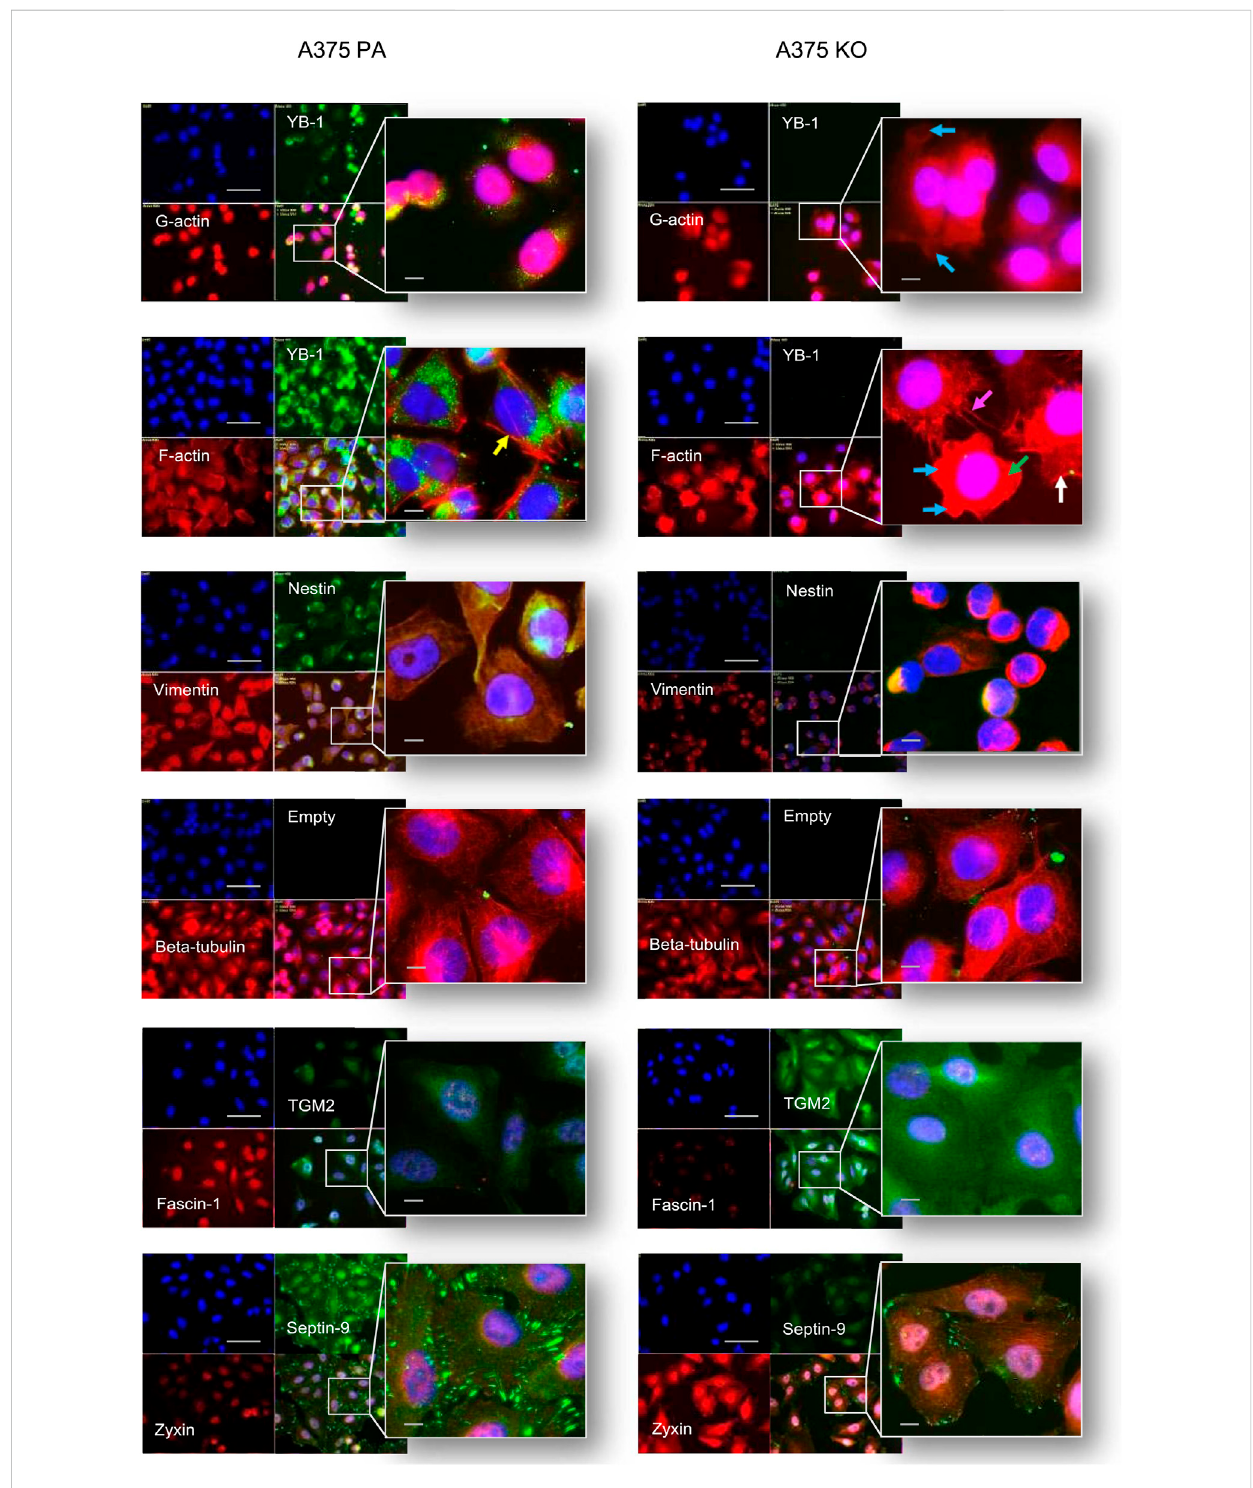
FIGURE 7 Immunolabelling of cytoskeleton protein in A375 parental and A375 YB-1 knock-out cell lines. From top to bottom, co-labeling of: YB-1 - green, F-actin - red, nuclei - blue; vimentin - red, nestin - green, nuclei — blue; beta-tubulin- red, nuclei-blue; fascin-1 - red, TGM2 - green, nuclei-blue; zyxin — red, septin-9 - green, nuclei-blue, were conducted for these 2 cell lines A375 parental (left side) and A375 knock-out (right side). Arrows denote morphological differences: loss of F-actin (marked by green arrows), blebbing (marked by the blue arrow), fi lopodia formation (marked by magenta arrow).,lamellipodia(markedbywhitearrows),stress(markedbyyellowarrows).Alexa488-greenlabeling,Alexa594-redlabeling,DAPI-blue(nucleus staining). The scale bar (white) represents 20 µm. Abbreviations: PA - parental; KO -